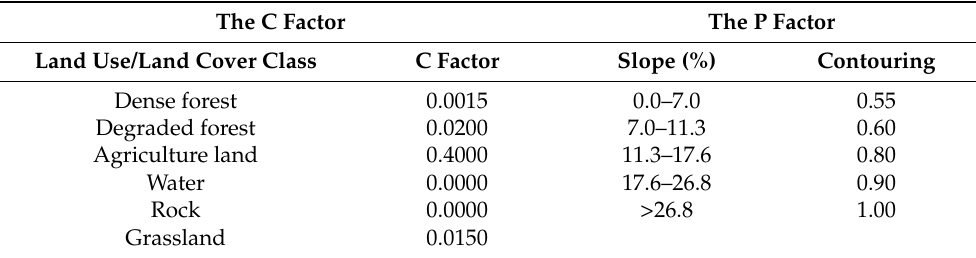
Table 3. The C factor for different land use land cover (LULC) classes and the P factor according to the slope (data source from [56,59]).